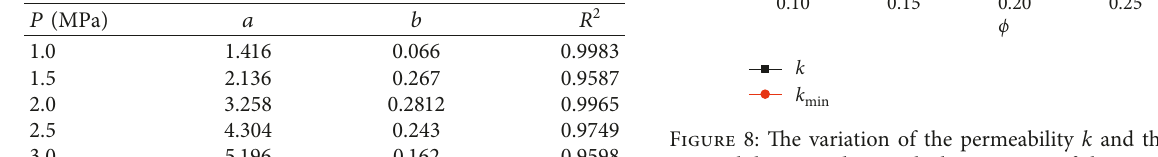
Figure 7: The variation curve of seepage velocity with the variation of the porosity under different seepage pressure. Table 2: The characteristic parameters of seepage velocity with the variation of the